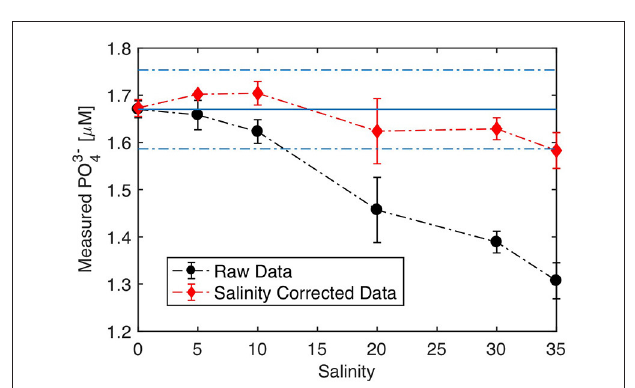
FIGURE 5 | Salinity response. Sensor operating using onboard standard and blanks prepared in UHP water. Samples were prepared by serial dilutions of low nutrient seawater, which was spiked with 1.67 µ M PO 3 − 4 at each salinity tested. The solid and dashed lines represent the spiked PO 3 − 4 concentration in the sample ± 5%, respectively. Error bars represent the standard deviation of replicate analyses ( n =